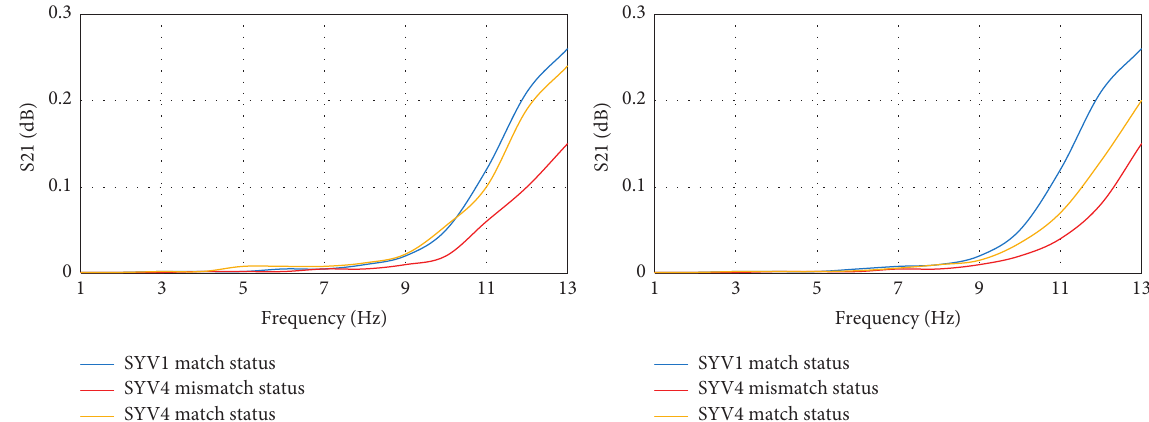
Figure 7: Power cable connected to 75 Ω and 50 Ω resistance transfer impedance.